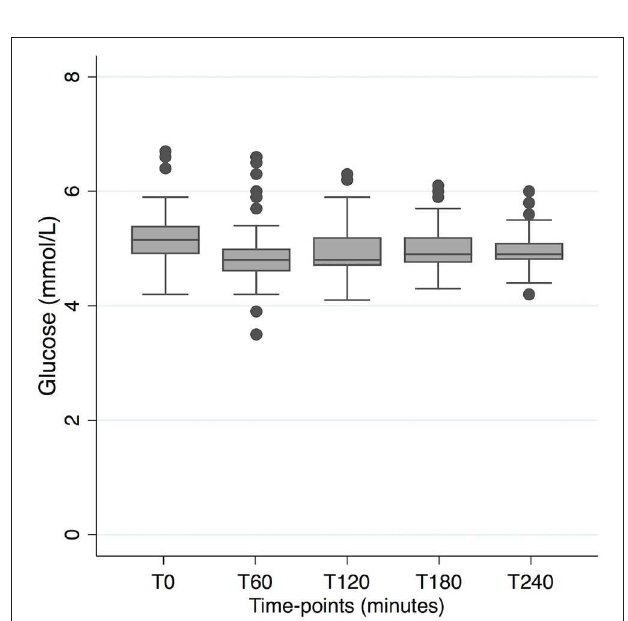
FIGURE 4 | The ratio between the two plasma ketones (BHBp/AcAc), plotted against BHBp. Comparisons of arms including coconut oil vs. caprylic acid (C8) vs. neither or both. For enhanced scaling, one case in arm 2 with a ratio of 11 (0.11/0.01), is excluded from the graph. BHBp, β -hydroxybutyrate in plasma; AcAc, Acetoacetate.